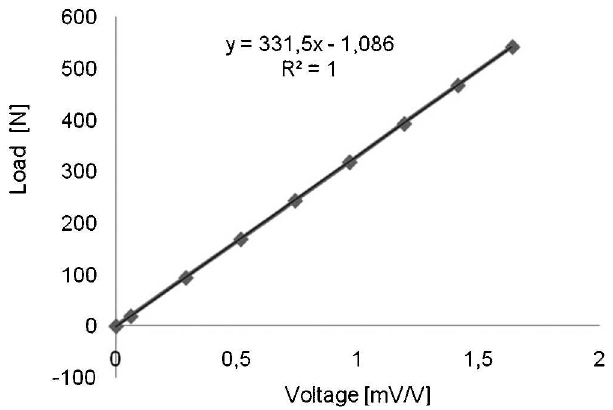
Figure 2 - Device calibration data in vertical